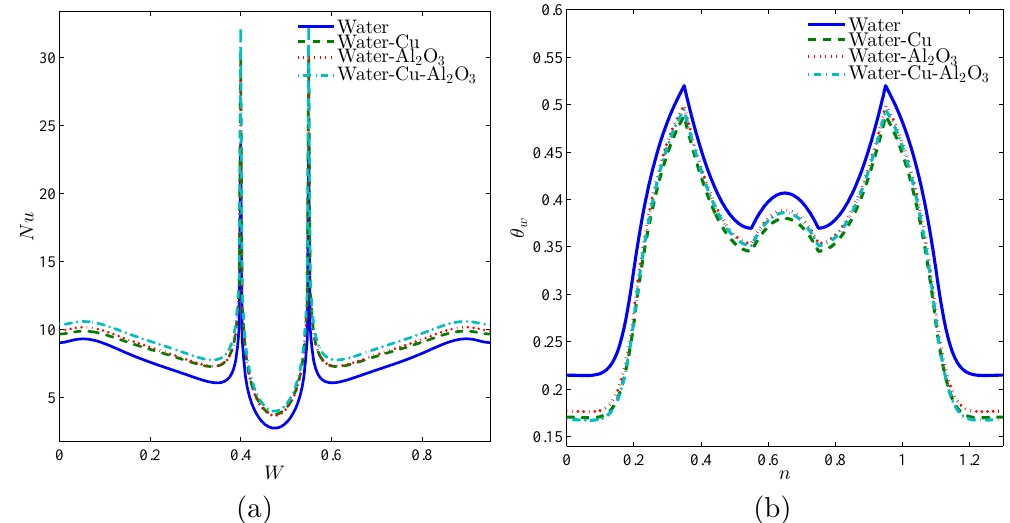
Figure 7. The evolution of the local characteristic parameters ( a ) local Nusselt number interfaces with W and ( b ) local dimensionless temperature on the solid blocks for different types of particles at Ra = 10 5 , φ = 0.02, and D = 0.4.